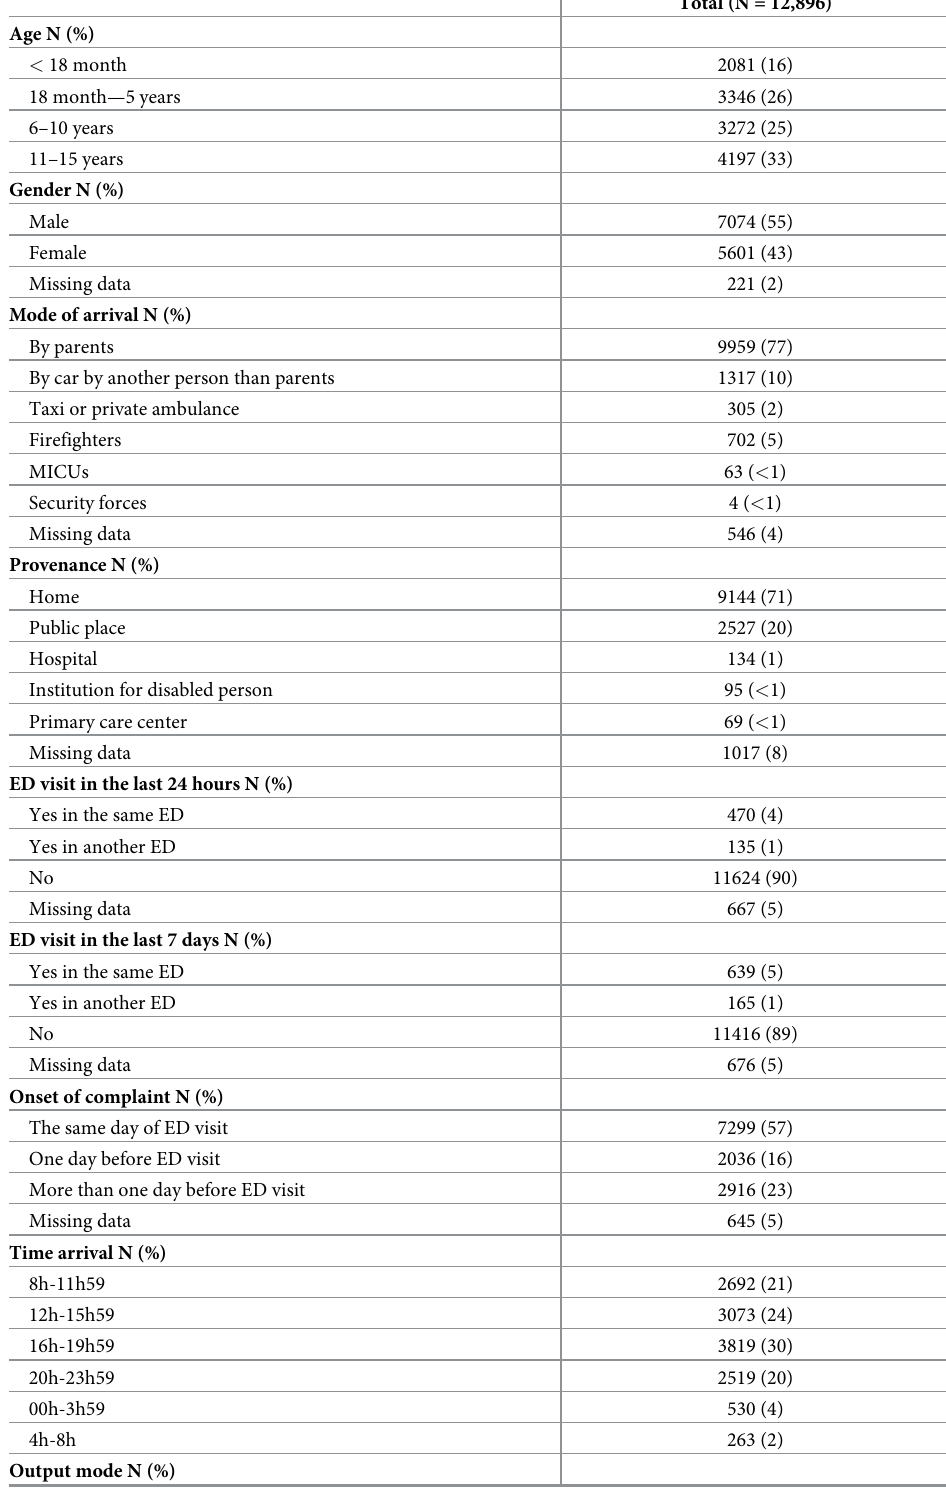
Table 5. Characteristics of users younger than 15